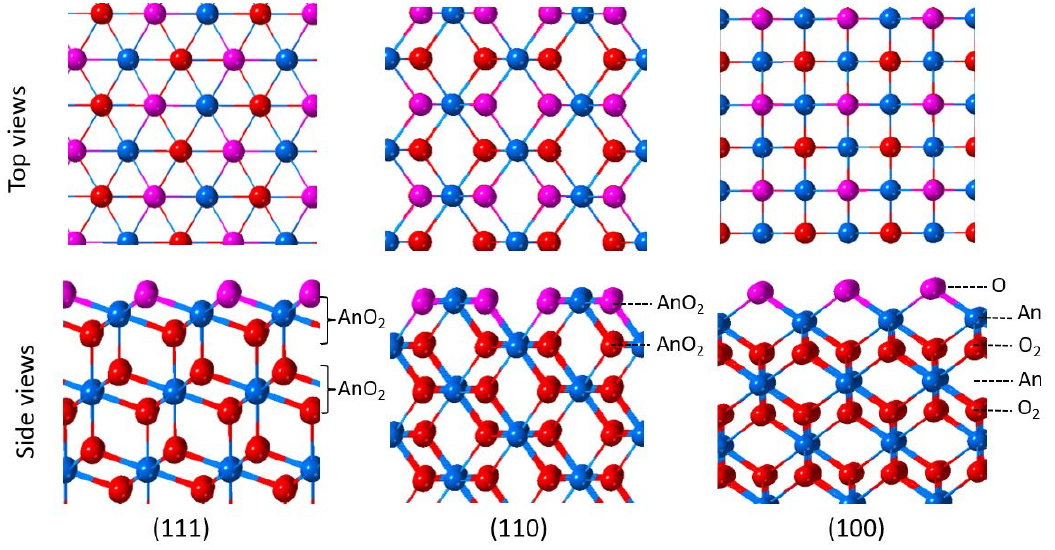
Figure 2. Top and side views of the (111), (110), and (100) surfaces of AnO 2 .